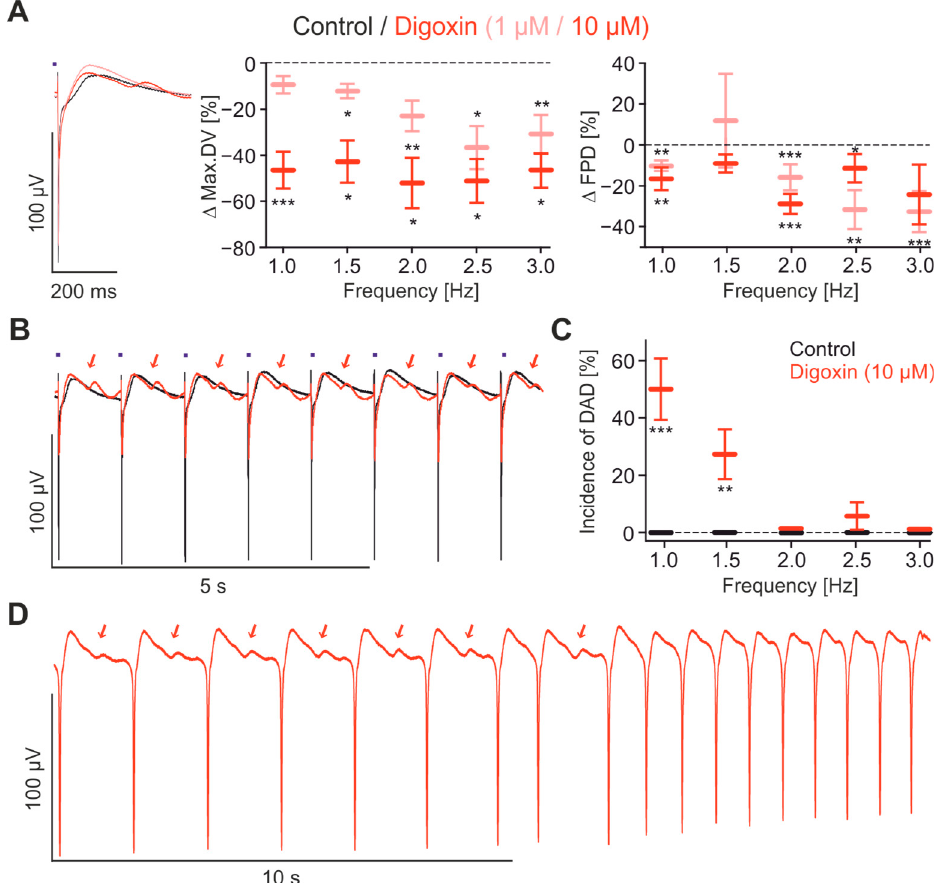
Figure 6. Effects of Digoxin. ( A ) Overlay of representative FP optically paced at 1 Hz ( left ) before (black) and after Digoxin application (red), and statistical analysis of the effects of 1 μ M and 10 μ M Digoxin on relative changes of max.DV ( middle ) and FPD ( right ) at the frequencies 1–3 Hz ( n = 10–11); ( B ) representative FP traces paced at 1 Hz in control conditions (black) and after application of 10 μ M Digoxin (red) with arrhythmic afterdepolarisations (red arrows); ( C ) statistical analysis of the incidence of afterdepolarisations at pacing rates of 1–3 Hz ( n = 15); ( D ) FP trace from a spontaneously beating monolayer the presence of 10 μ M Digoxin. Note the afterdepolarisations (red arrows) after each FP in the first phase ( left ) and the double beating rate in the second phase ( right ) indicating a FP triggering by each afterdepolarisation * p < 0.05, ** p < 0.01, *** p < 0.001.